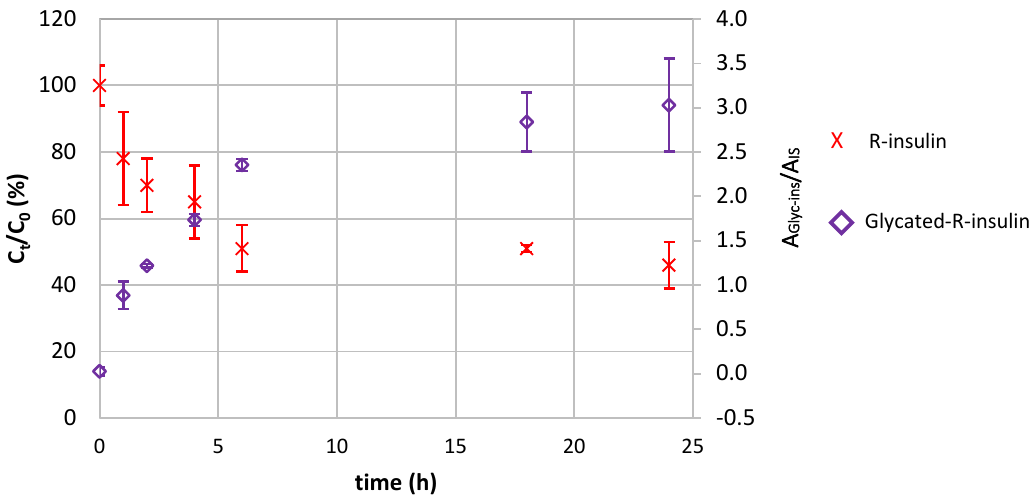
Figure 5. Change over time in the concentrations of R-insulin (red crosses) and glycated-R-insulin (“Glyc-ins a ”, purple diamonds) in a binary PN admixture. Experimental conditions: 0.7 mg/L R-insulin at t 0 in a binary PN admixture (medium 1) containing 17.5% dextrose at pH 6.3, and 25 °C; the LC-MS/MS analysis were performed after dilution with a pH 7.3 solution.